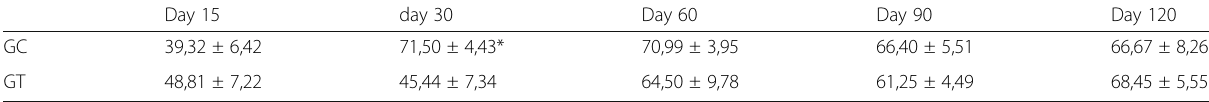
Table 2 - Mean + standard deviation of the mean of the trabeculae density of the spongy substance (%) in the control (GC) and treated (GT) groups. The Mann-Whitney test was applied between the groups in each